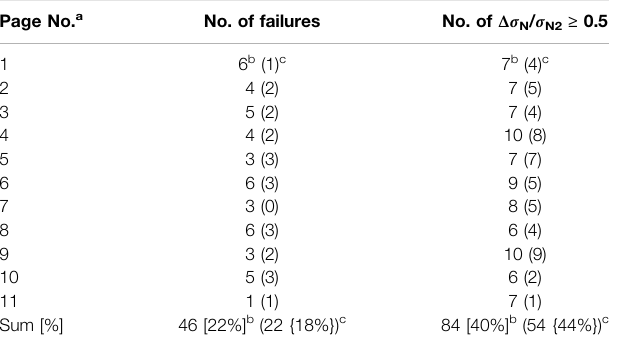
TABLE 1 | Summary of number of MC failures and number of those with Δ σ N / σ N2 ≥ 0.5 Page No. a No. of failures